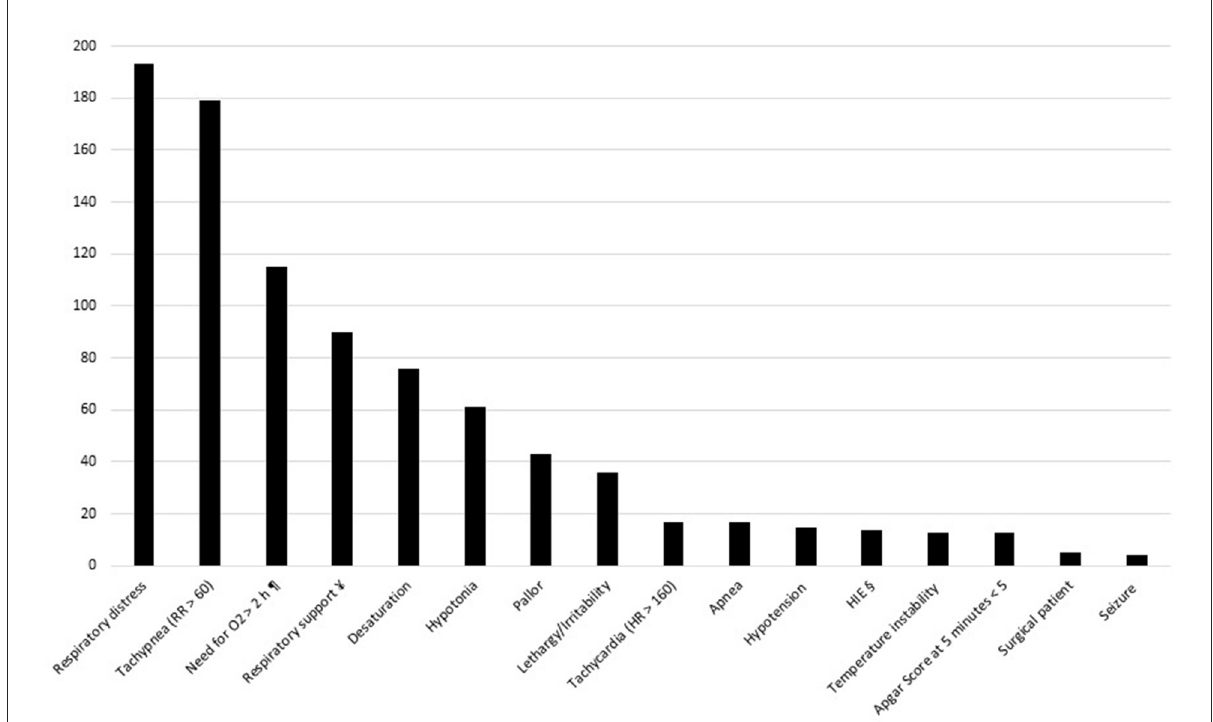
FIGURE1 Symptoms and respiratory supports among symptomatic neonates. HIE, hypoxic ischemic encephalopathy. ¶ to maintain SpO2 > 90%. U persistent need for NCPAP / HFNC / mechanical ventilation. § hypoxic ischemic encephalopathy requiring